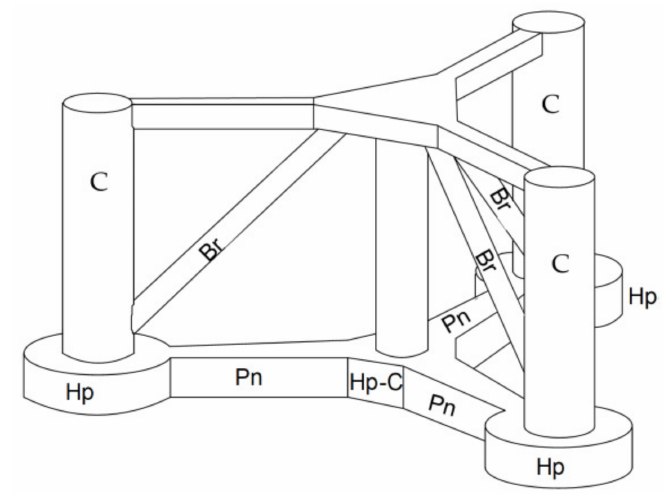
Figure 1. Components of the semi-submersible